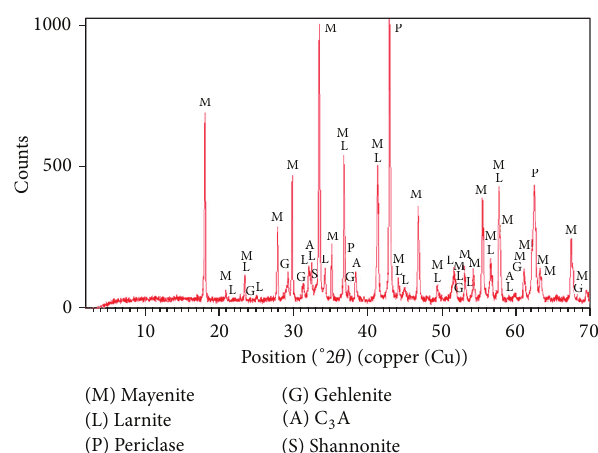
Figure 1: The XRD pattern of the LF slag.